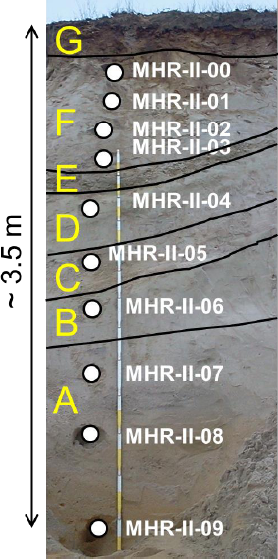
Figure 5. Photograph of the sampled profile with indication of sam- pling points, field codes, lithological units (A–G) and approximate profile